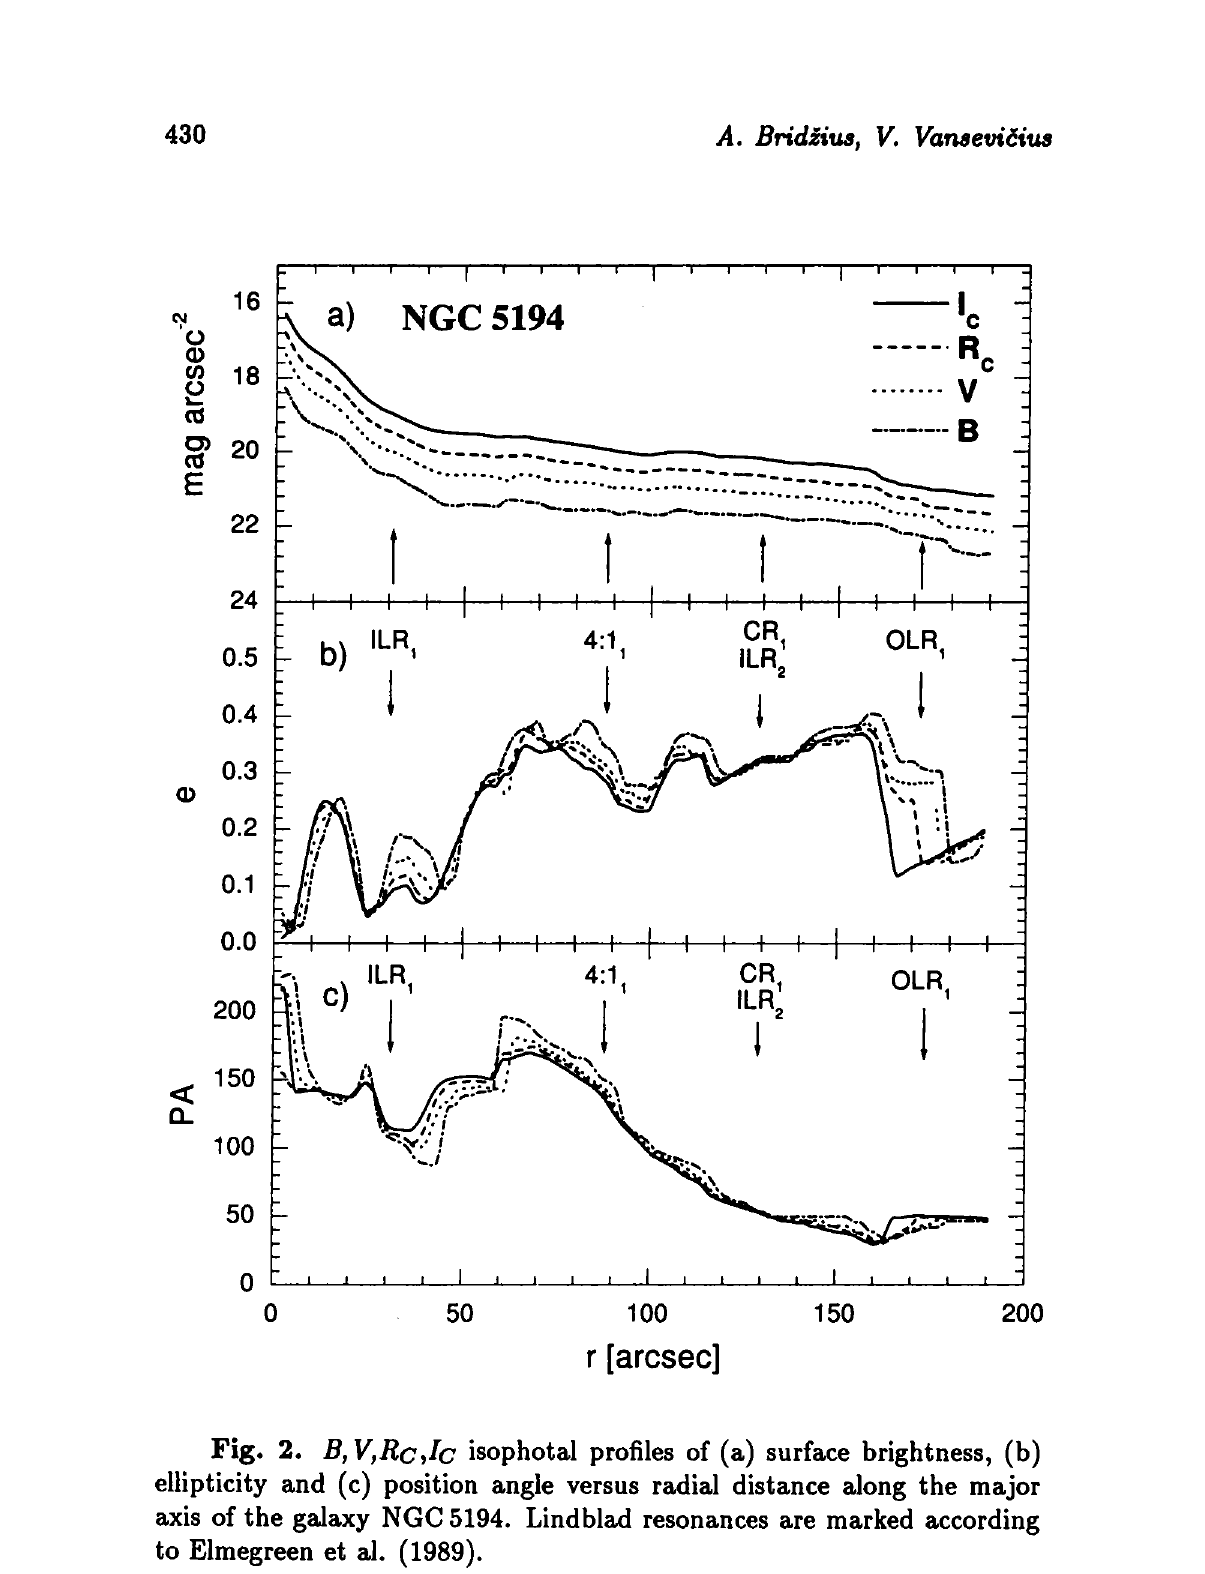
Fig. 2. B,V,RcJc isophotal profiles of (a) surface brightness, (b) ellipticity and (c) position angle versus radial distance along the major axis of the galaxy NGC 5194. Lindblad resonances are marked according to Elmegreen et al.